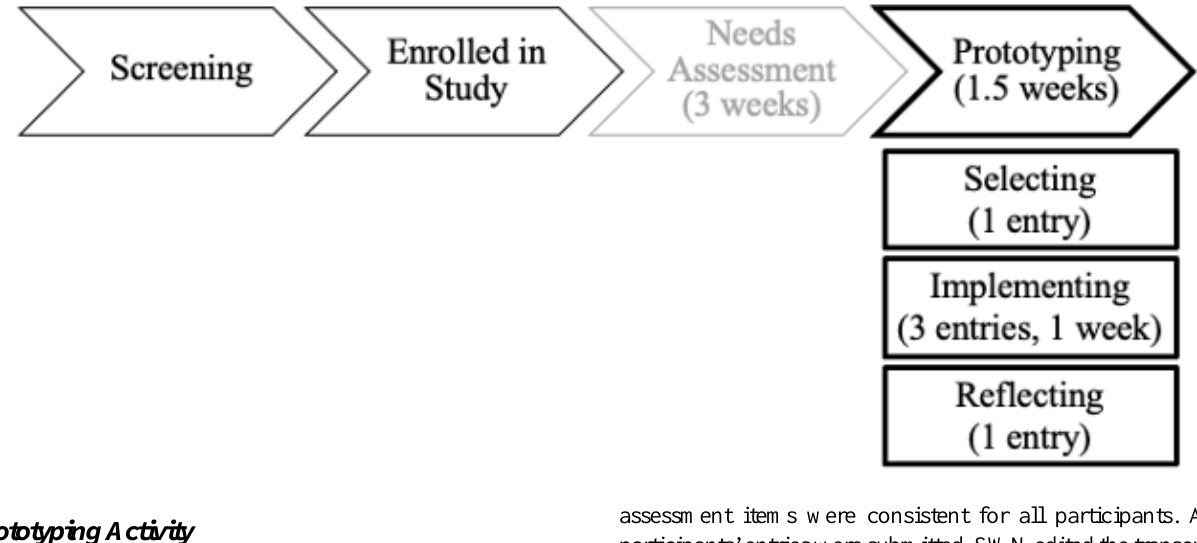
Figure 2. Schematic of participant flow through the study activities, including prototyping, the focus of this analysis, and the three research prompts it comprises. Of the 25 participants who enrolled, 22 began and completed